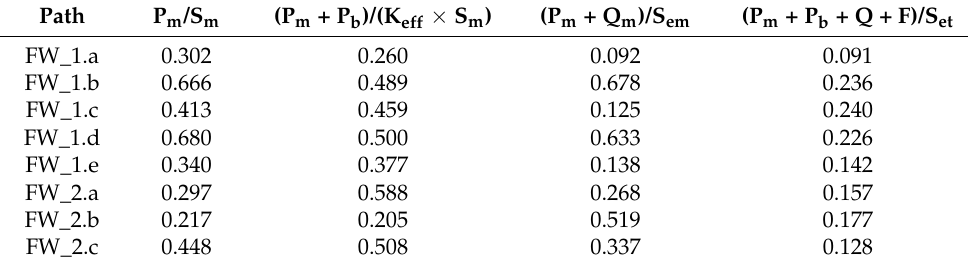
Table 8. RCC-MRx Level D criteria verification within FW-SWs domain.